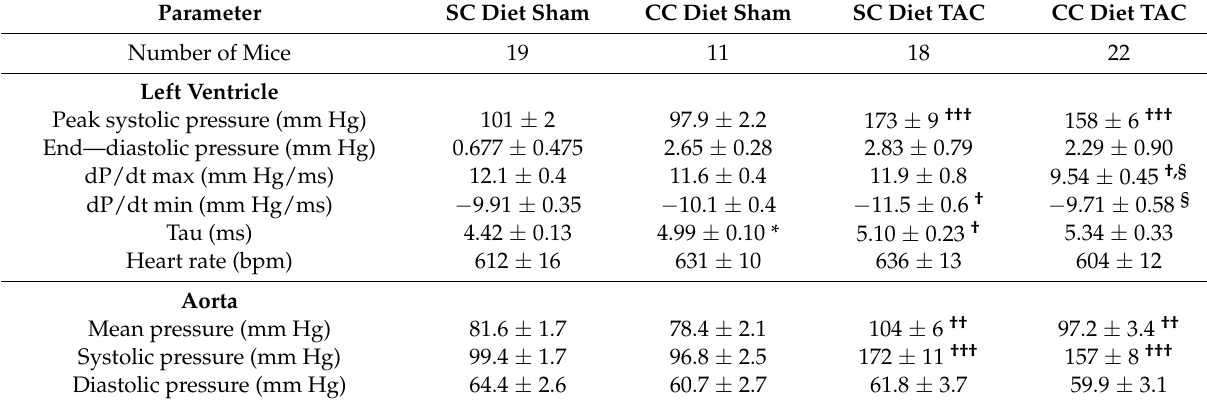
Table 4. Hemodynamic parameters in the left ventricle and in the aorta eight weeks after sham operation or after TAC in C57BL/6 mice fed the SC diet or the CC